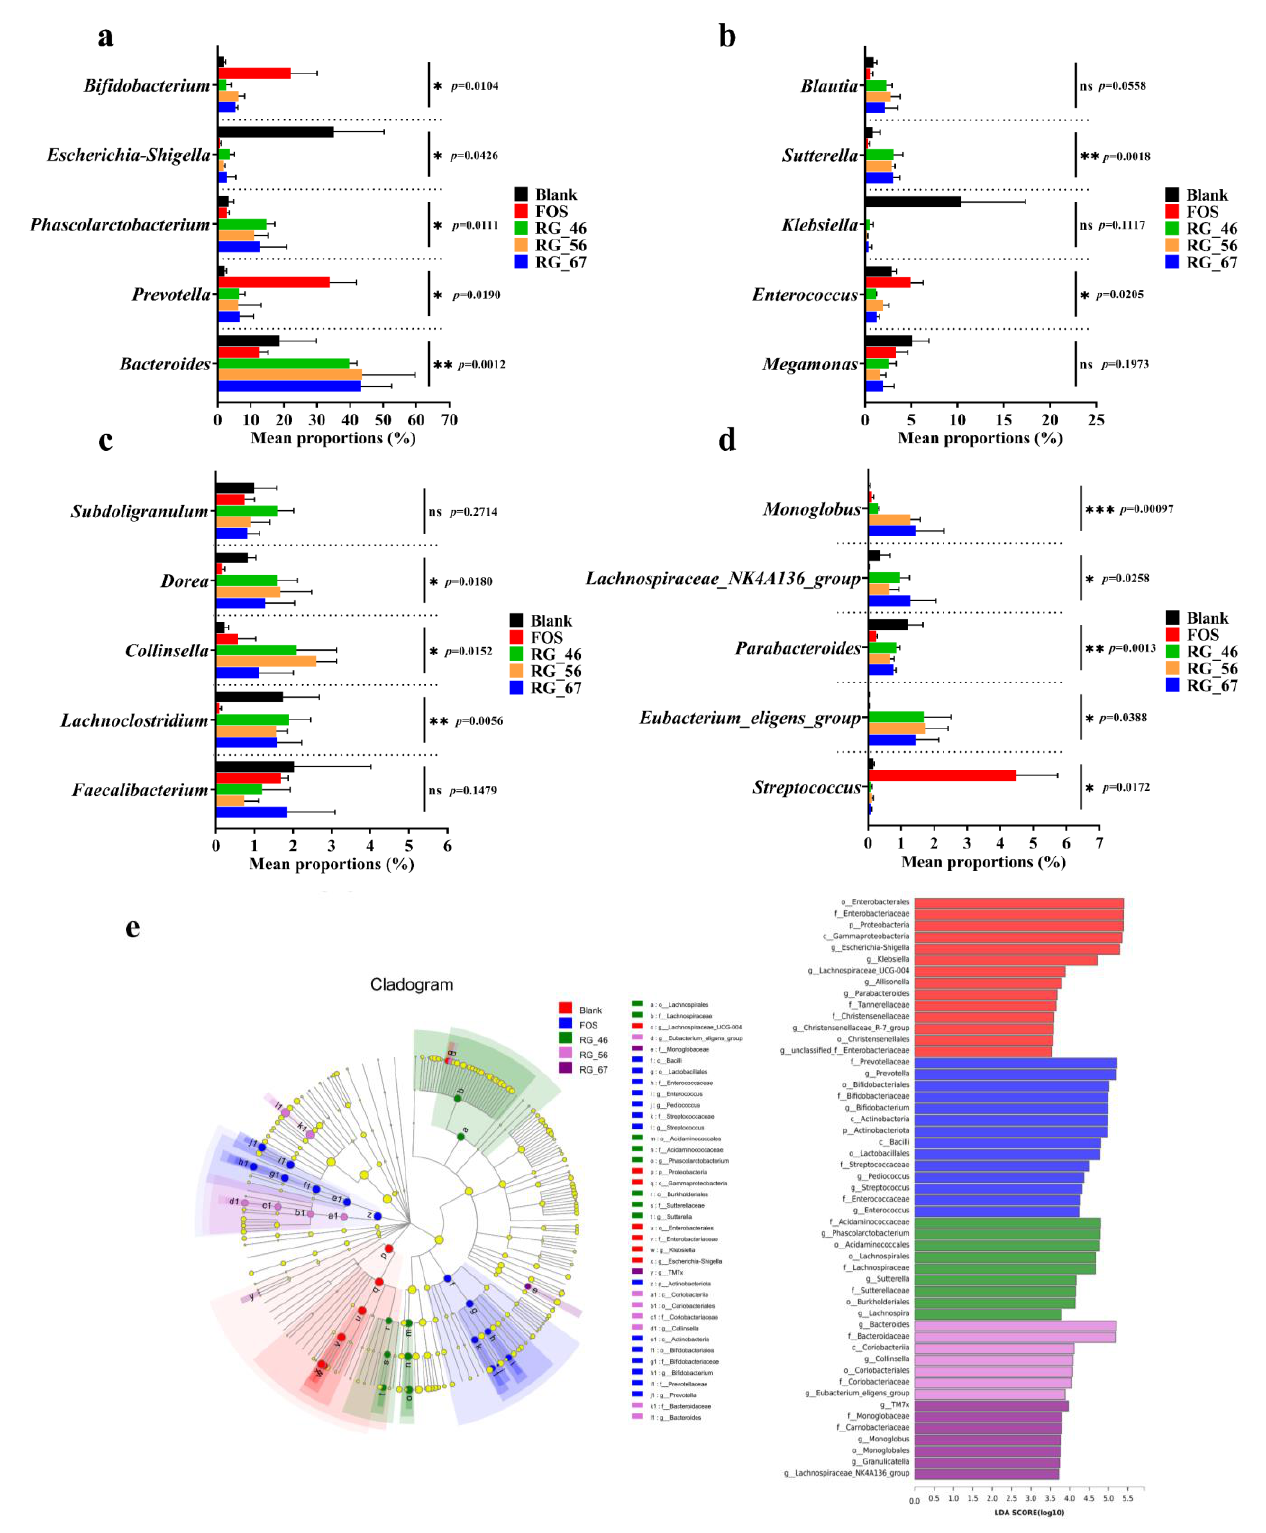
Figure 4. Comparison analysis among five groups of gut microbiota. ( a – d ) One-way ANOVA results based on the abundance of the top 20 genera; ( e ) linear discriminant analysis effect size (LEfSe) multilevel discriminant analysis of microbiota differences. Statistically significant differences among different samples are shown with asterisks, as follows: (*) p < 0.05, (**) p < 0.01, and (***) p < 0.001.